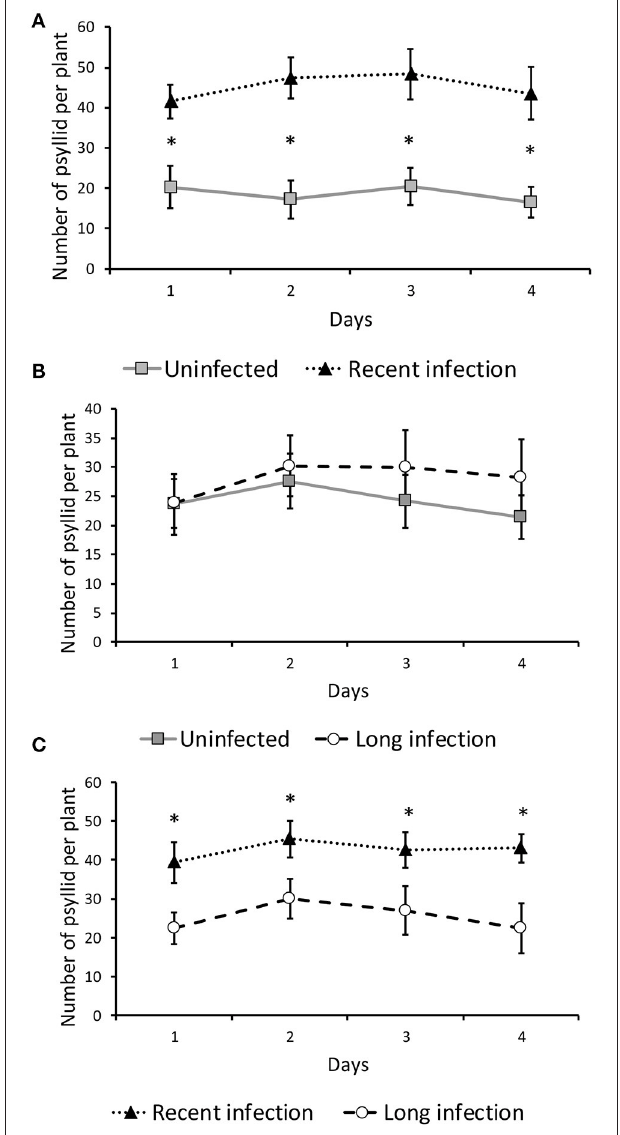
FIGURE 2 | Mean number ( ± SE) of Diaphorina citri counted on citrus plants during 4 days of observation when given a choice between citrus plants infected by Candidatus liberibacter asiaticus < 6 months (newly infected) vs. uninfected plants (A) , or infected > 12 months (long-infected) vs.